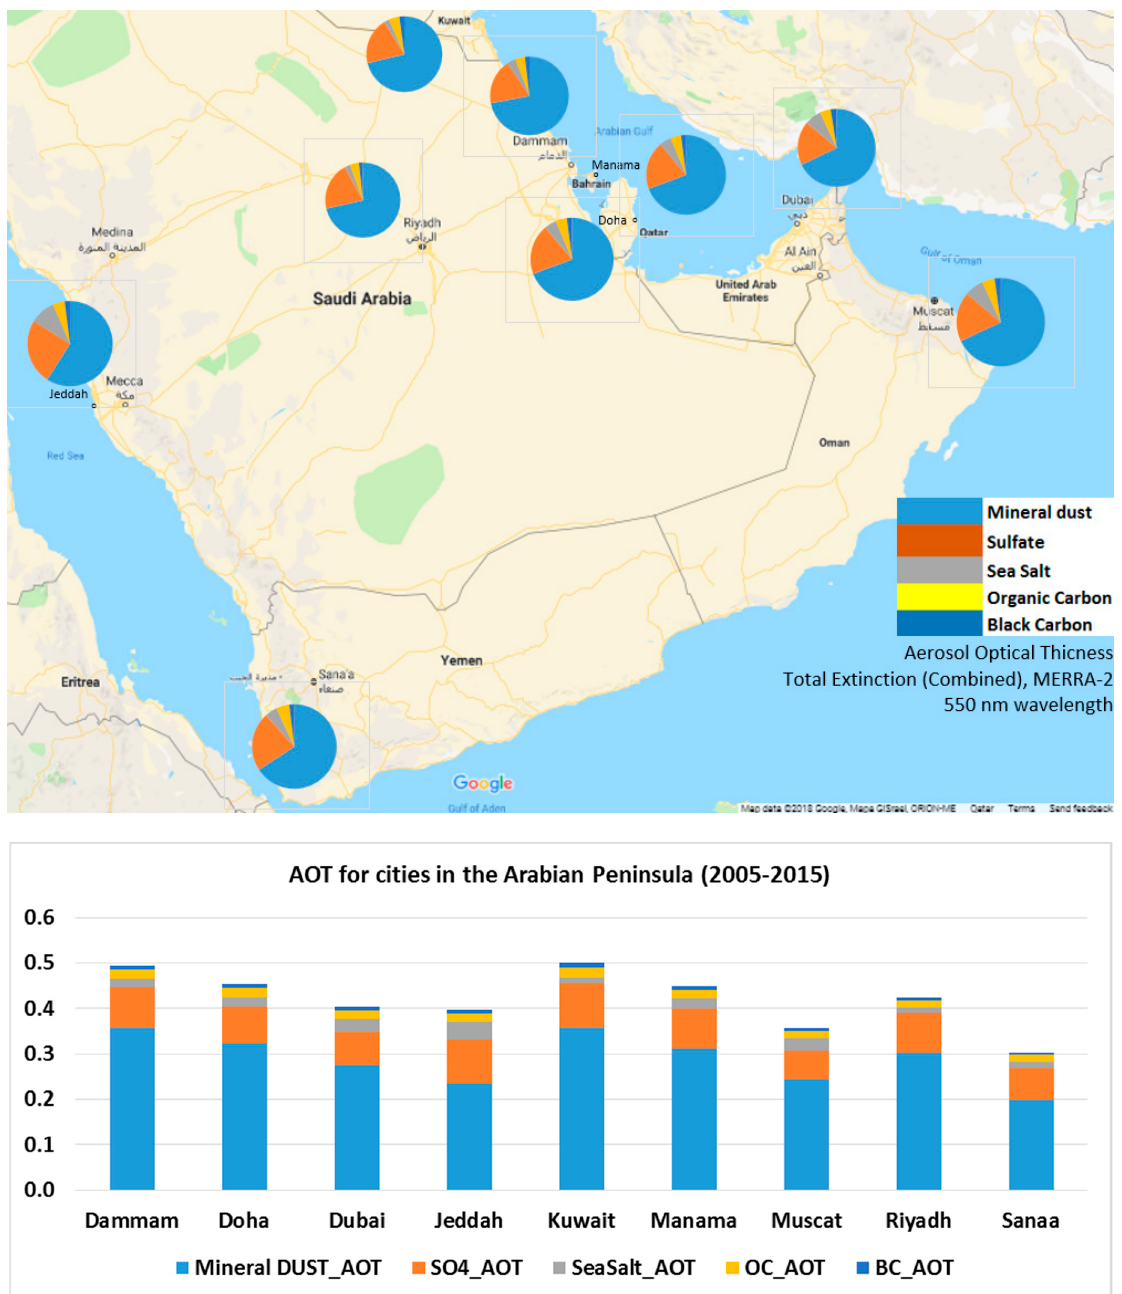
Figure 5. ( Top ) Map of the Arabian Peninsula showing the location of the nine urban environments and the contribution of the various aerosol components; ( Bottom ) total and speciated AOT among the nine cities in the Arabian Peninsula (average from 2005–2015).